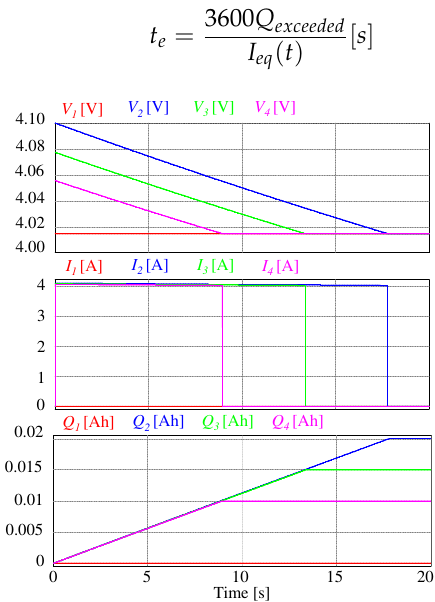
Figure 5. Equalization of a four-cell battery bank using the switched resistor scheme.